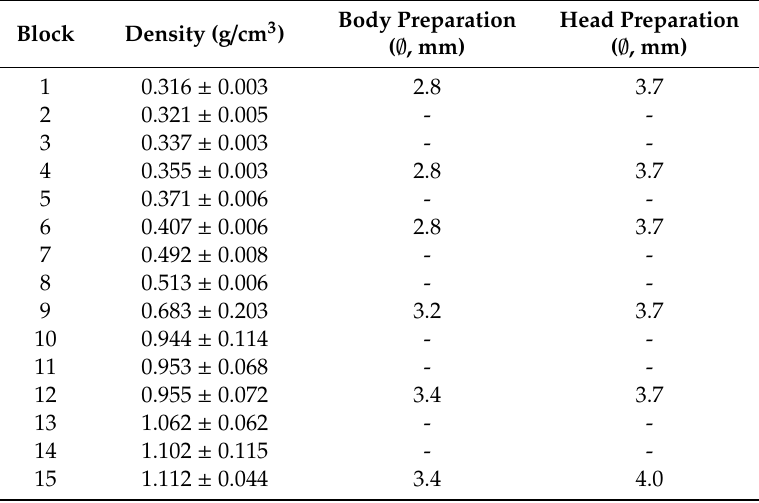
Table 1. Density of bone blocks used in the present study and the last drill sequence used to prepare blocks implants were inserted